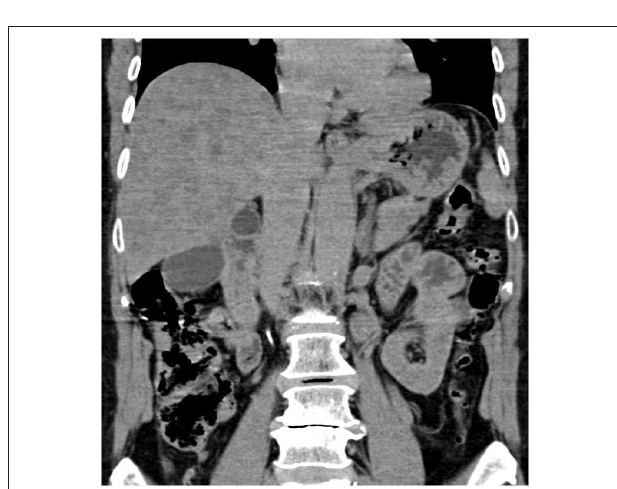
FIGURE 2 | Abdominal computed tomography, non-enhanced coronary scan. Markedly inhomogenous liver with map-like hyperdense areas and multiple hypodense focal changes.